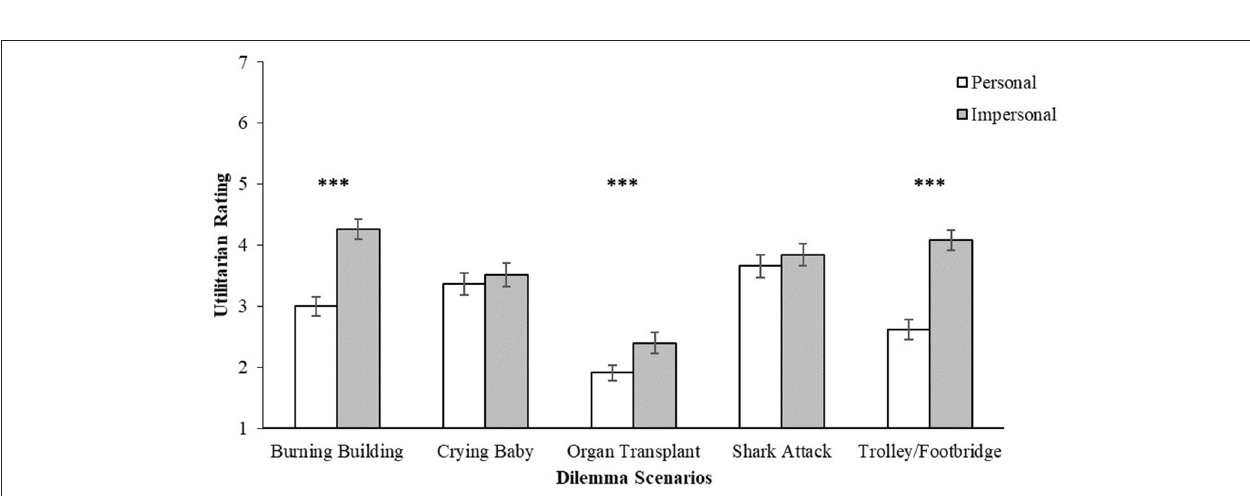
FIGURE 2 | Utilitarian ratings (1 = definitely no, 7 = definitely yes) by dilemma scenarios and personal force (personal/impersonal). Error bars represent standard errors of the means. *** p < 0.001.